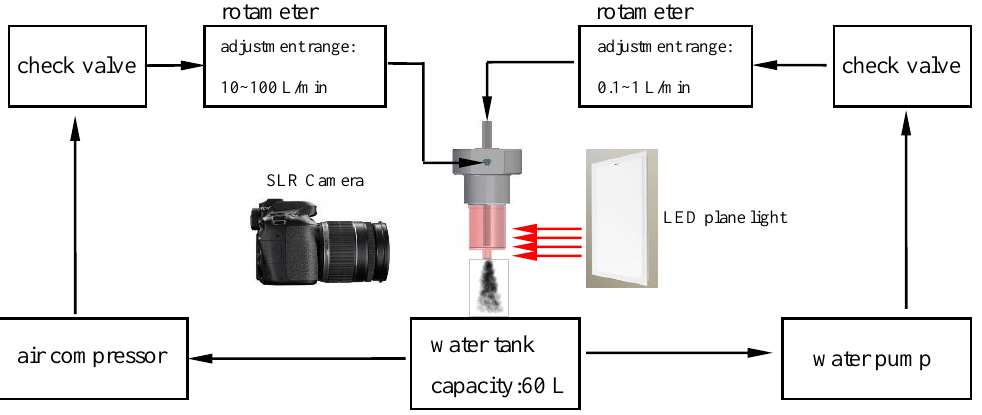
Figure 2. Schematic diagram of experimental platform.